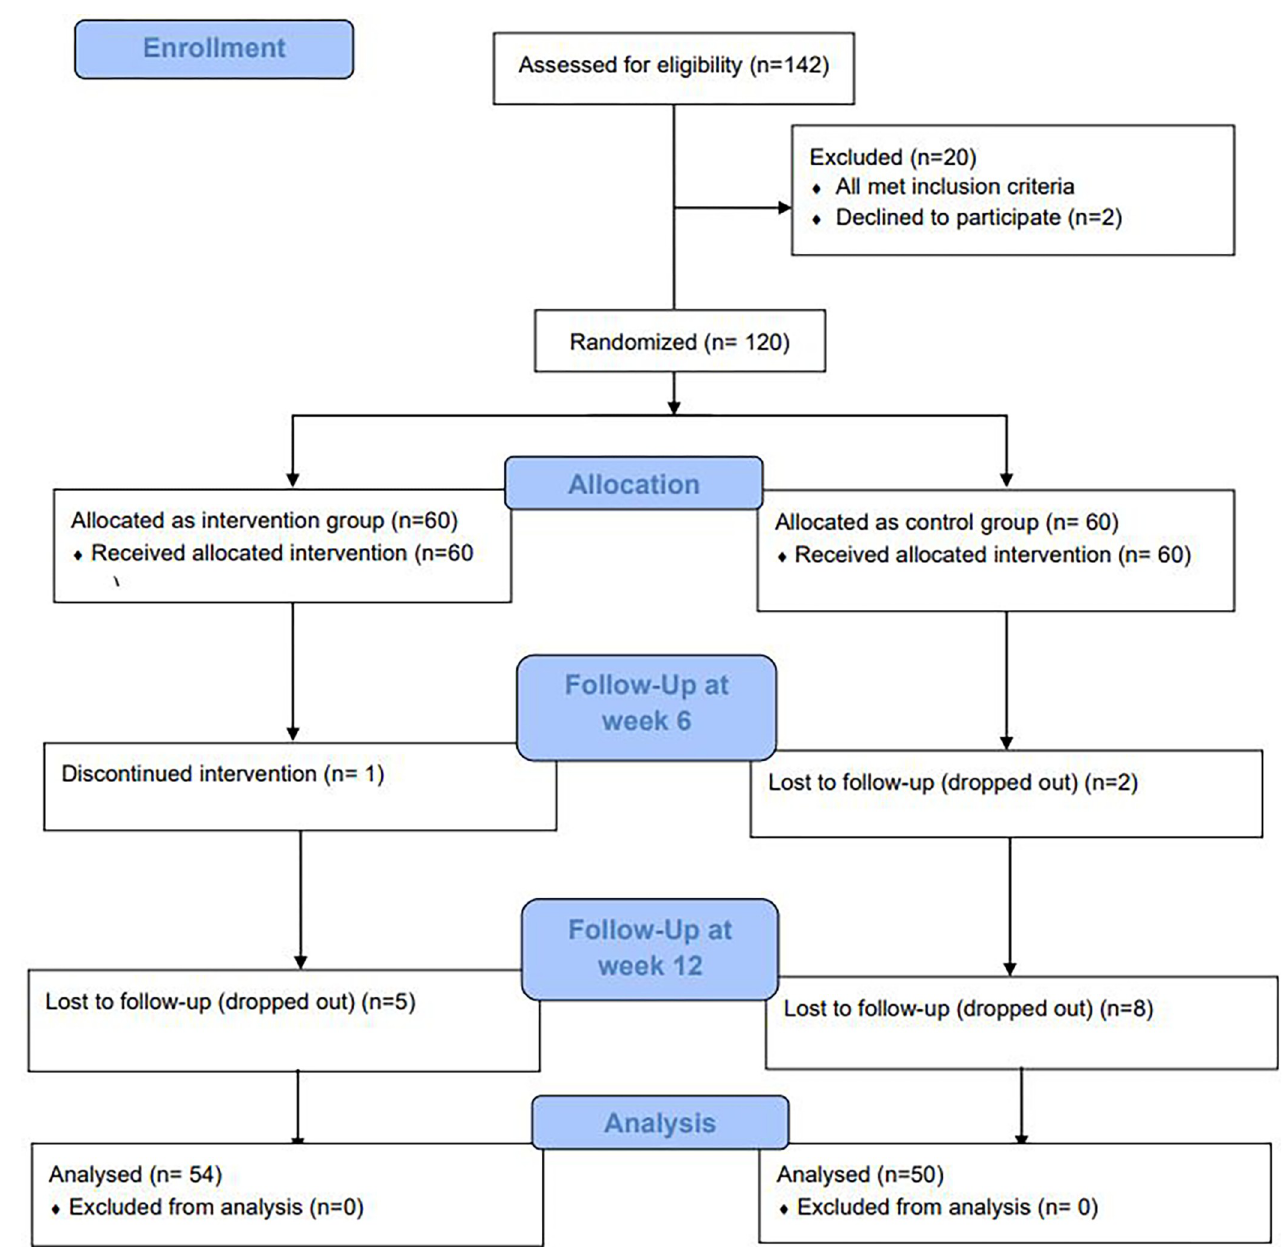
Fig 1. CONSORT participant flow